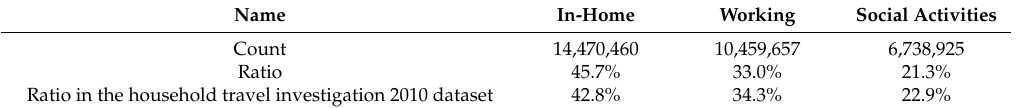
Table 2. Comparison of human activities from human sensing data with household travel investigation.